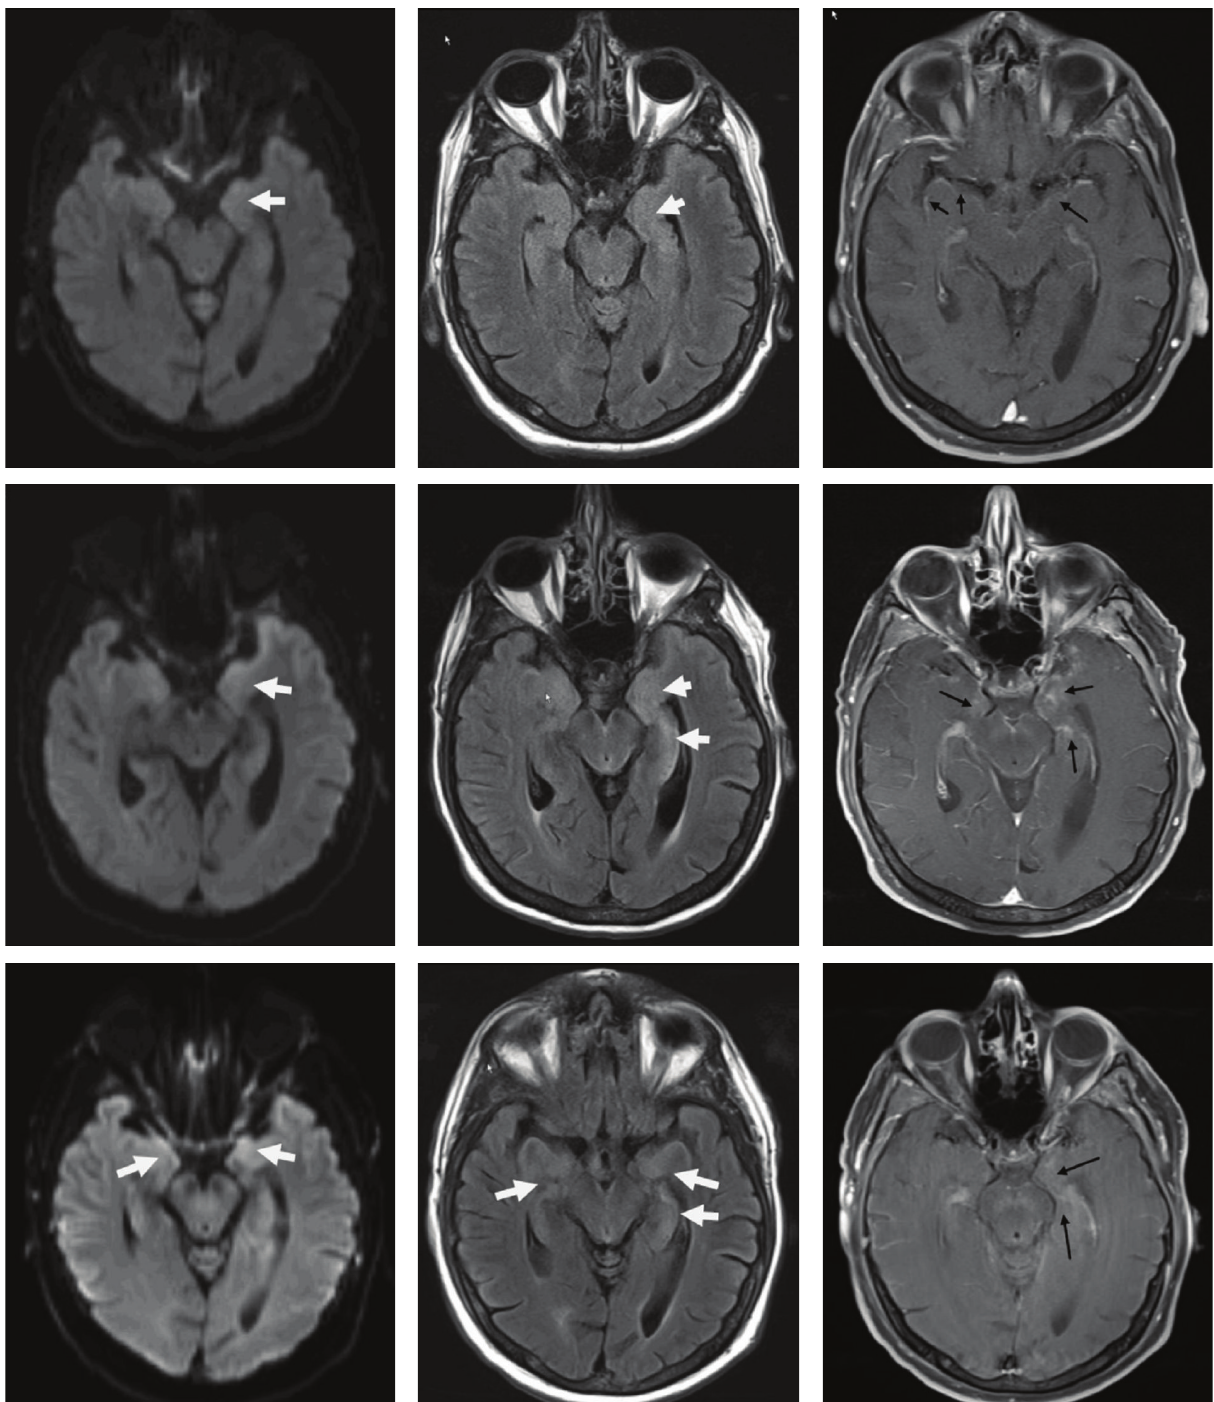
Figure 1: The first row shows brain MRI (from left to right, DWI, FLAIR, and T1+C) from first ER visit with presumed TGA: arrows show subtle signal changes that were too mild to be called. The middle row shows brain MRI (from left to right, DWI, FLAIR, and T1+C) six weeks from his first presentation: signal changes in DWI, FLAIR in hippocampus; moreover, there is enhancement in hippocampus and medial temporal lobe. The lowest row shows that brain MRI after treatment shows subtle improvement in hippocampus and temporal